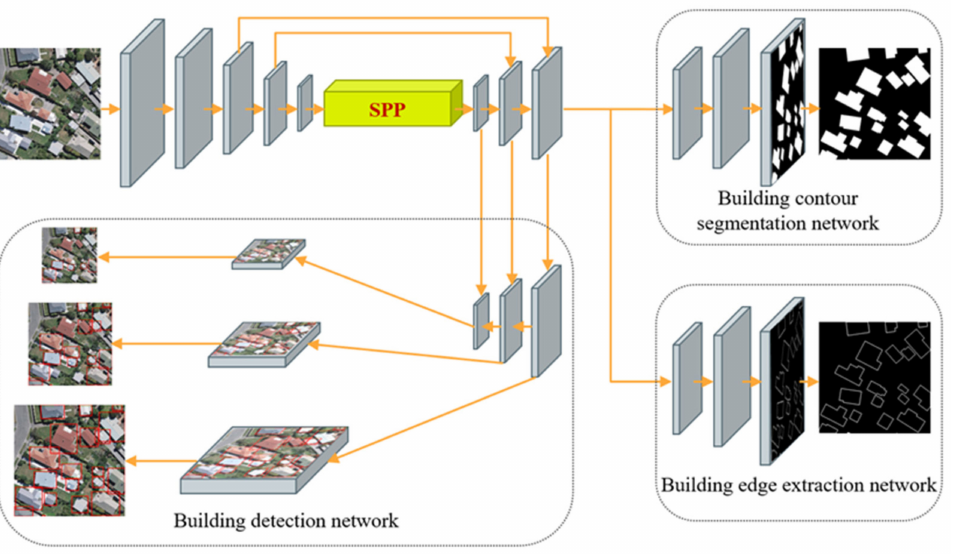
Figure 1. Flowchart of automatic building extraction based on the MultiBuildNet framework for very high-resolution remote sensing